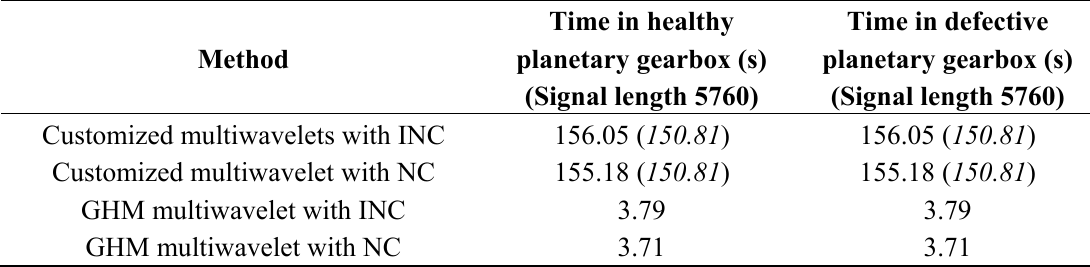
Table 3. The computing time of the methods in planetary gearbox fault